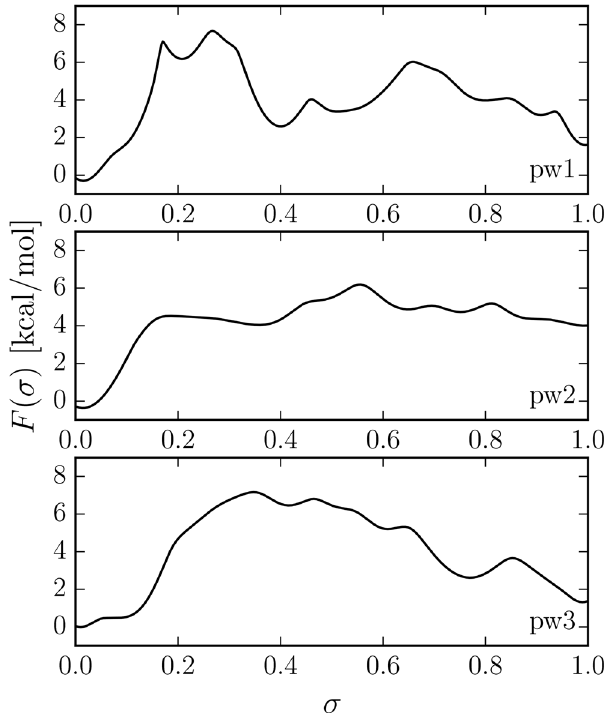
Figure 2. Free-energy profiles F ( σ ) along the camphor diffusion pathways pw1-3. [The order parameter σ (cf. Methods) is introduced by scaling s